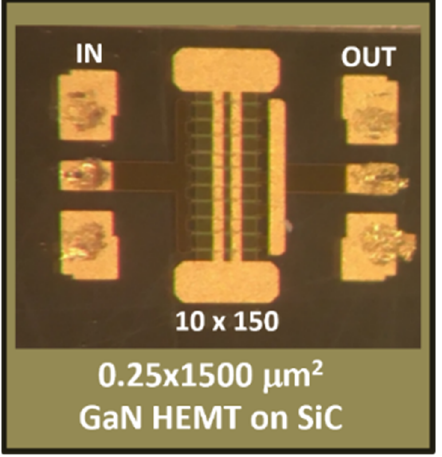
Figure 1. Photograph of the tested GaN HEMT on silicon carbide substrate.